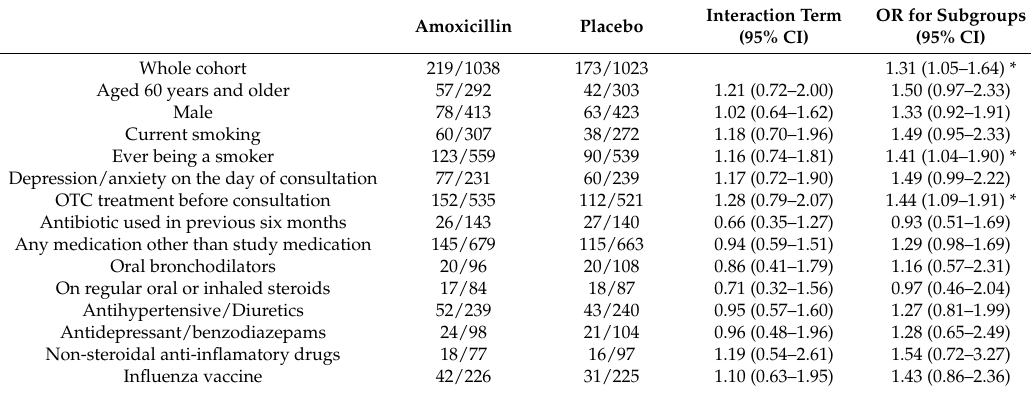
Table 1. Any adverse event (diarrhoea or nausea or rash) in the whole cohort, and in subgroups of adult patients in the first week after presenting to primary care with a LRTI and allocation to amoxicillin or placebo.